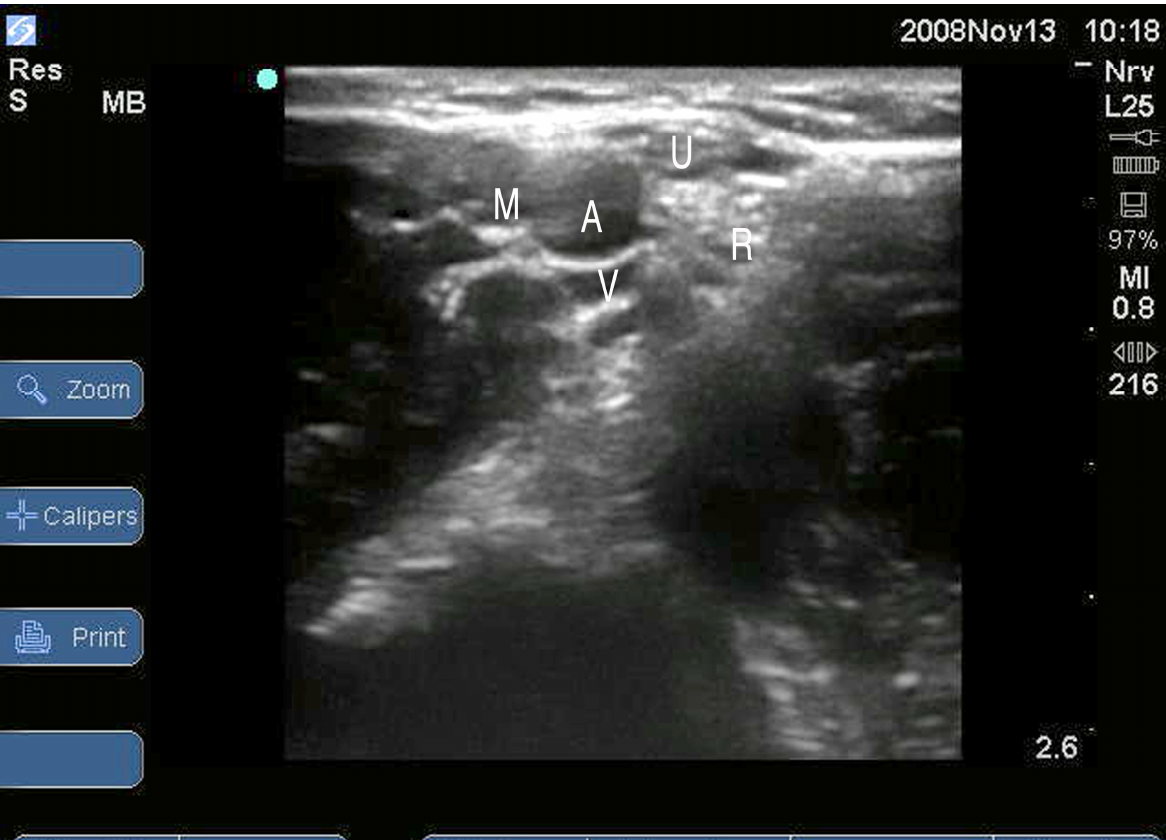
FIGURE 5. Ultrasound image of axillary region, showing nerves in neurovascular sheath. A, axillary artery; V, compressed axillary vein; M, median nerve; U, ulnar nerve; R, radial